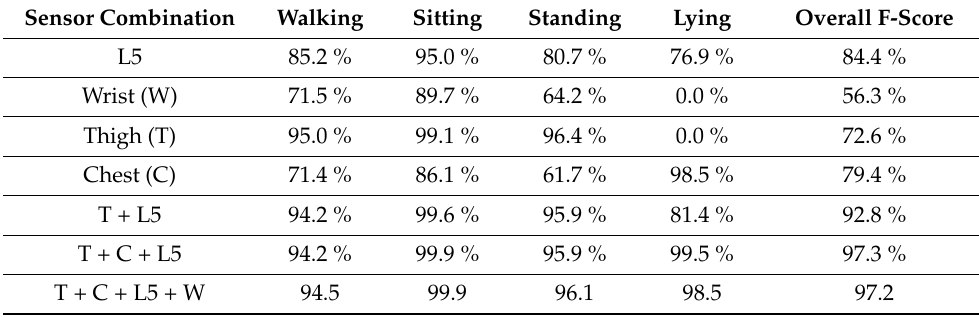
Table A2. Performance analysis (F-score) of LSTM-based PAC system using different sensor